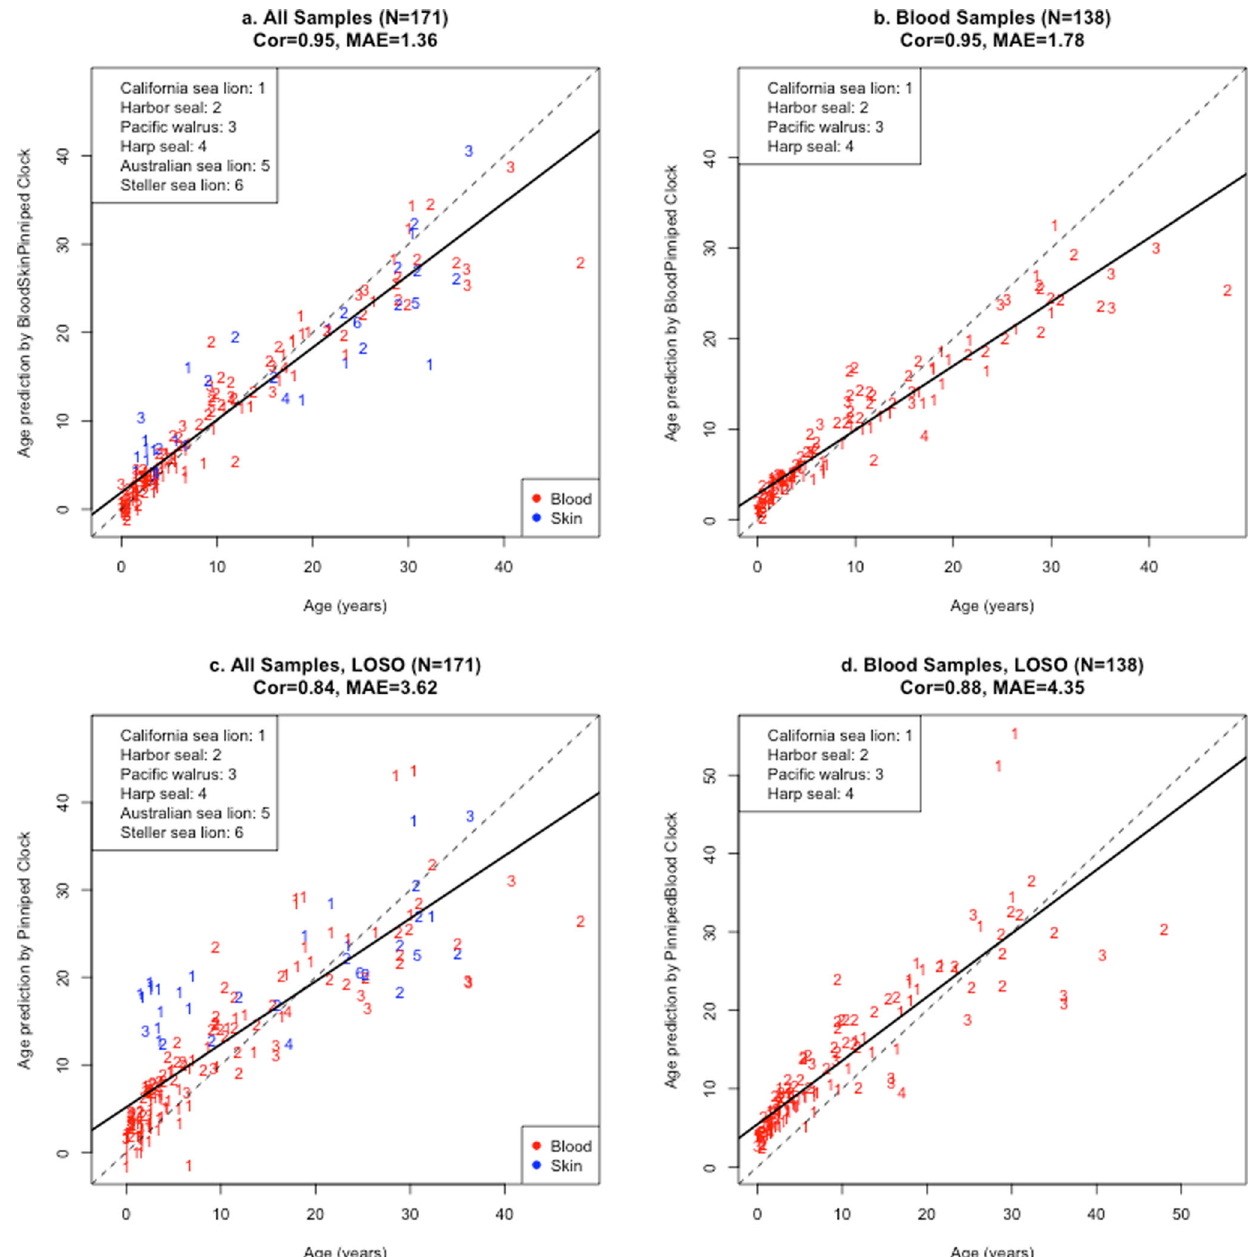
Fig. 1 Cross-validation study of the epigenetic clock for pinnipeds. a , b report the Leave-One-Out-Cross-Validation (LOOCV) regression estimates for the pinniped clocks when applied to blood and skin ( a ) and blood only ( b ). This cross-validation method is used to estimate the clocks overall performance at predicting age from novel samples (skin or blood) collected from the animals used in clock development. c , d report Leave-One-Species-Out (LOSO) regression estimates for the pinniped clocks when applied to blood and skin ( c ) and blood only ( d ). These cross-validated analyses provide estimates for the clocks ability to predict age in species of pinnipeds that were not used for clock development. Species are presented with different integer numbers and identi fi ed in the legend; tissue types are indicated by two colors with red = blood, blue = skin. Each panel depicts a linear regression line (black dashed line), a diagonal reference line ( y = x ), the sample size ( N ), Pearson correlation (Cor) across all samples, and the median absolute error (MAE) across samples from all